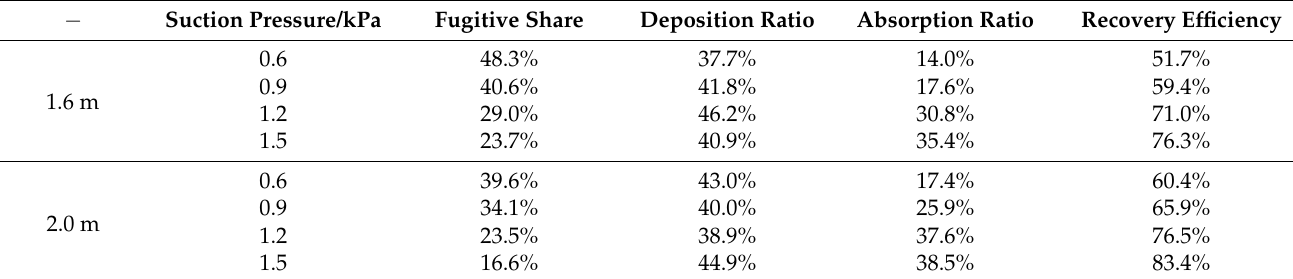
Figure 30. Relation between inhale pressure and the air velocity.